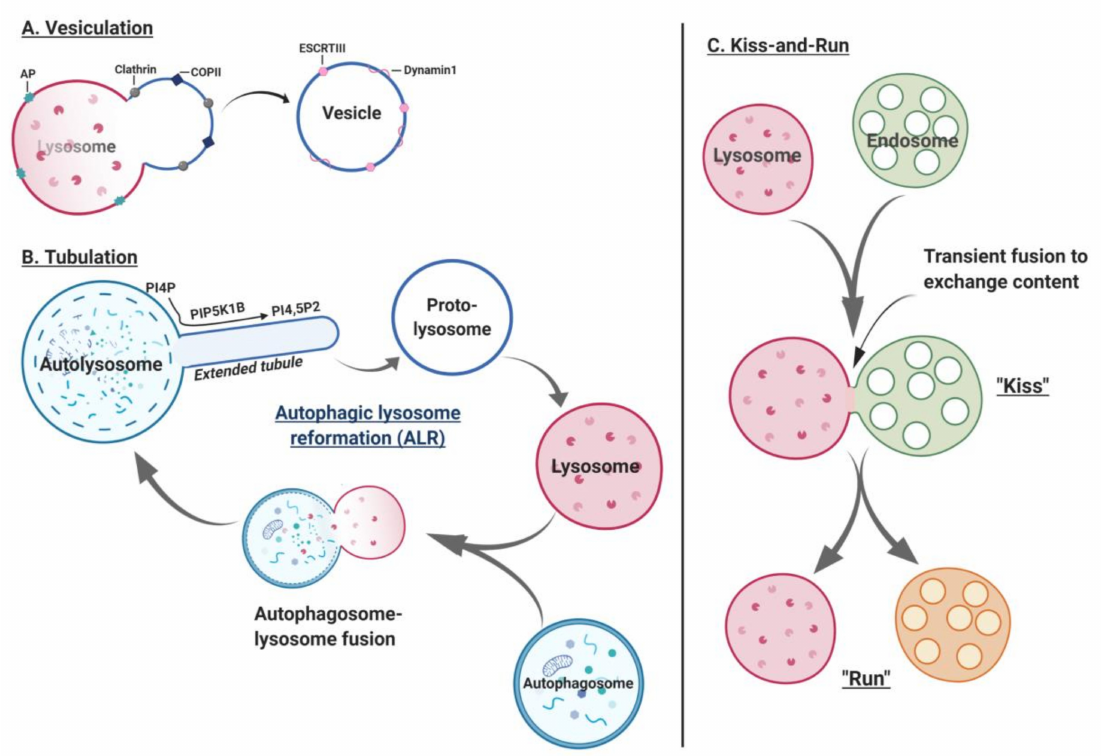
Figure 5. Lysosome fission. Lysosome fission involves, vesiculation process ( A ) is initiated by inner-coat adaptor protein-dependent cargo sorting, followed by membrane deformation mediated by clathrin and structural sca ff old of COPII subcomplex. Subsequently, scission machinery including dynamin 1 and ESCRT-III catalyzes the membrane fission and dissociates vesicle from the lysosomal membrane. The process of tubulation ( B ) is best described by autophagic lysosome reformation (ALR), wherein proto-lysosomes derived from ALs, mature into functional lysosomes known as lysosome reformation. These matured lysosomes then subsequently fuse with autophagosomes to form ALs and initiate the cycle of lysosome reformation. The final event of lysosome fission is kiss-and-run ( C ), which involves the fusion of lysosomes and late endosomes. The transient interaction (“Kiss”) between lysosome and LEs allows the exchange of content, followed by separation of the lysosome